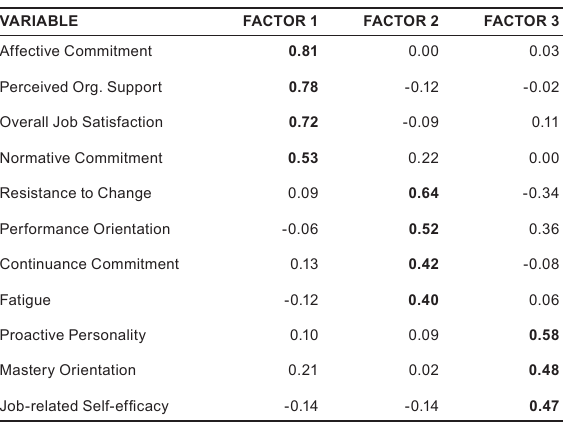
TABLE 3 Factor analysis of predictor